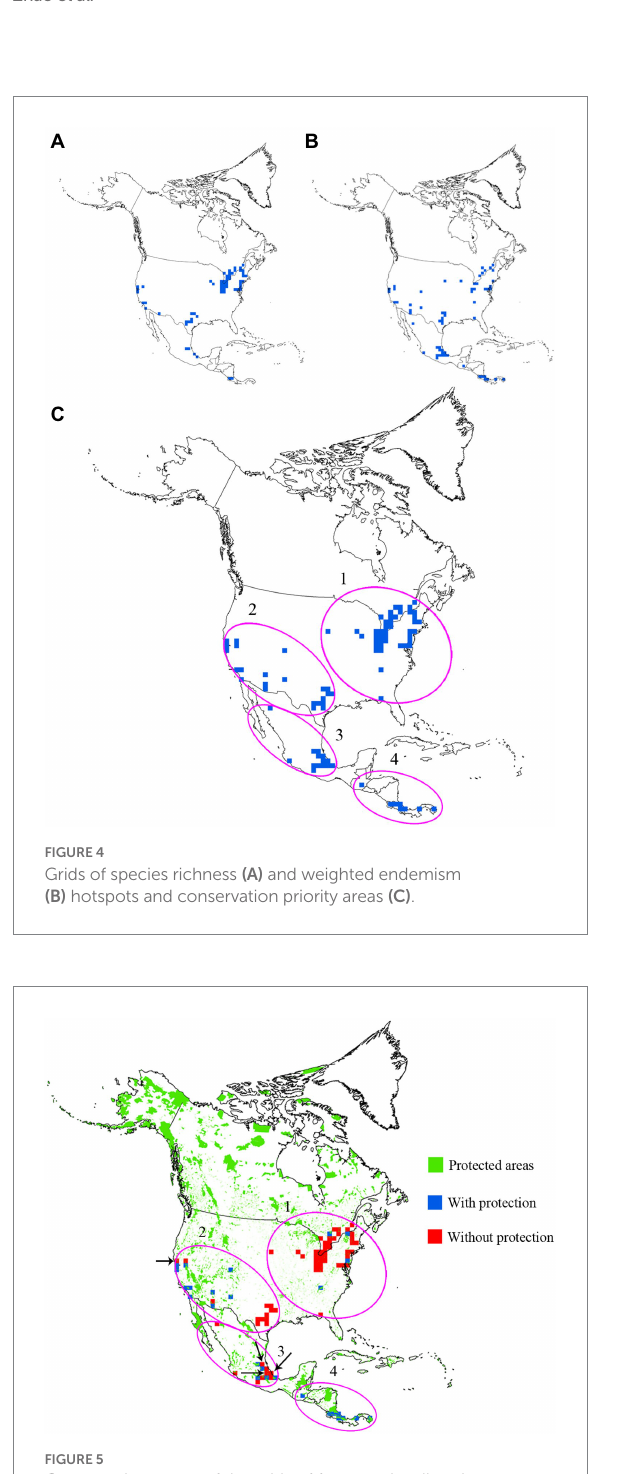
FIGURE 5 Conservation status of the grids of four species diversity hotspots. The black arrow indicates a grid with threatened species.